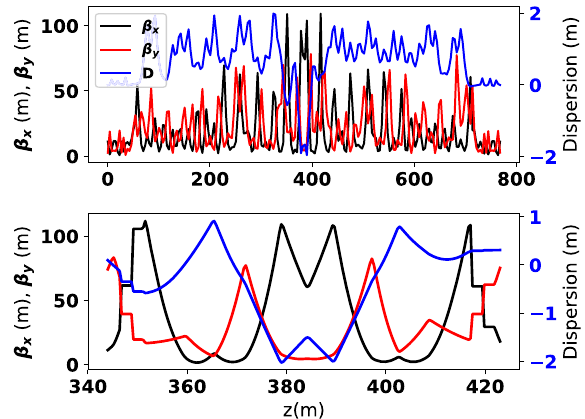
FIG. 2. The lattice functions throughout CESR (top) and zoomed in on the arc bypass (bottom). The PU and KU centers are located at 348 and 420 m,